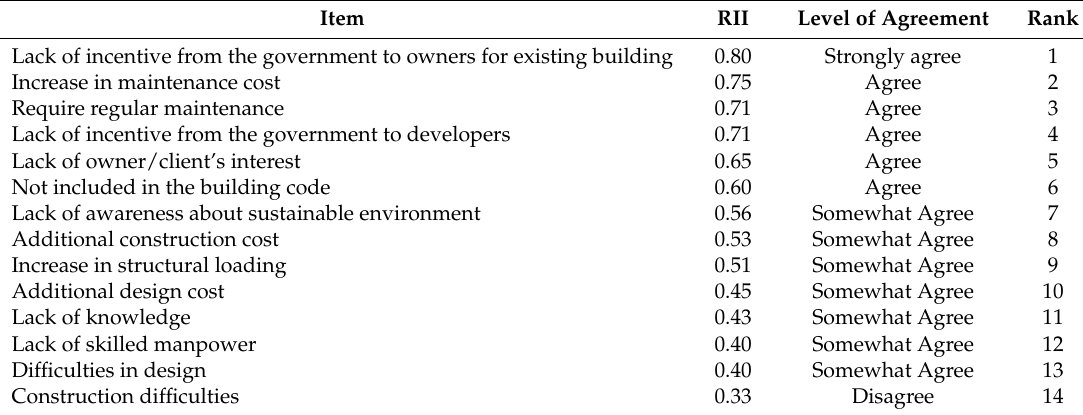
Table 6. Difficulties or constraints in implementing extensive green roofs.